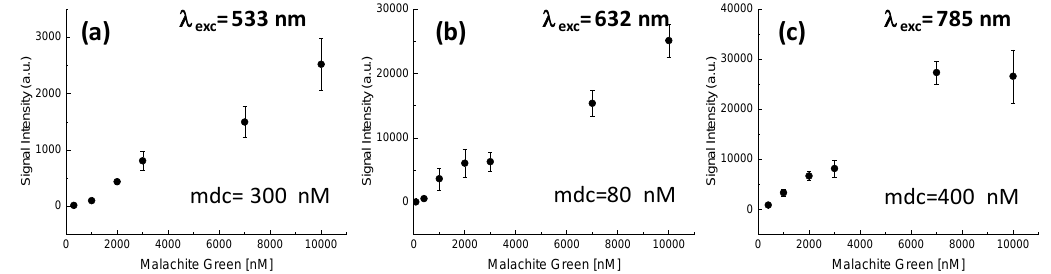
Figure 9. Calibration of the intensity of the Malachite Green band at 1170 cm −1 for different concentrations in the 16–10000 nM range for excitation with 533 ( a ), 633 ( b ), and 785 ( c ) nm lasers and details of the corresponding limit of detection.